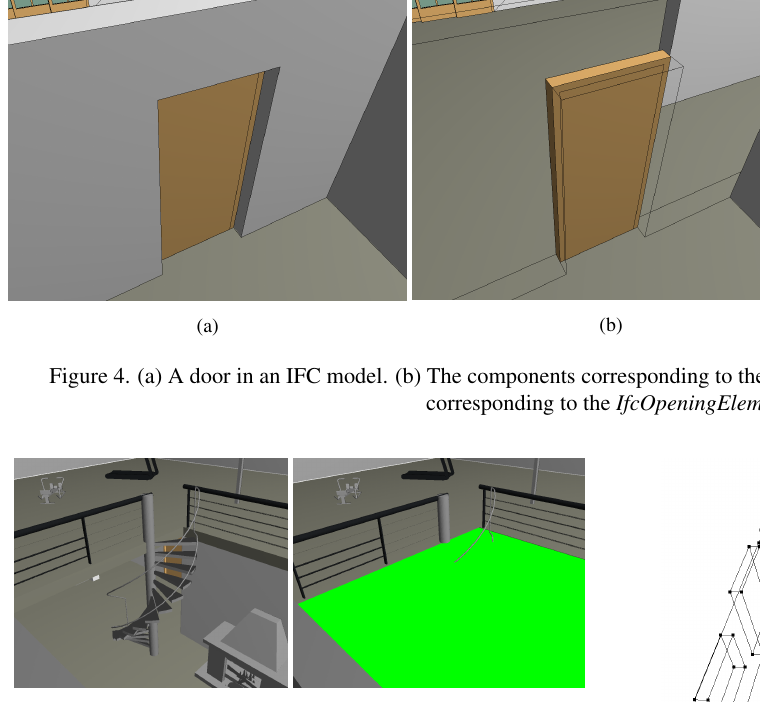
Figure 5. Case of an IfcVirtualElement (green, right) linking two storeys through stairs (left).